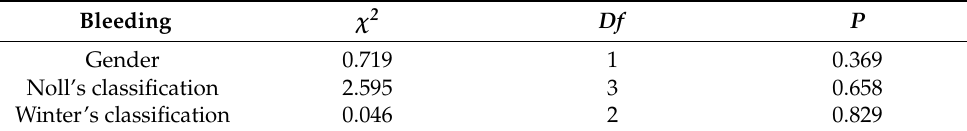
Table 6. Association between bleeding and gender, Nolla’s classification and Winter’s classification